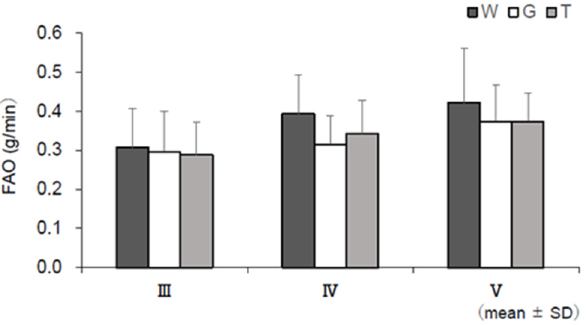
Figure 12. Fatty acid oxidation (FAO) assessments. W—water; G—glucose; T—trehalose. Compari- son of FAO (g/min) in each trial (water (W), glucose (G) and trehalose (T)) in III, IV, and V ( n = 12). W vs. G: * p < 0.05.